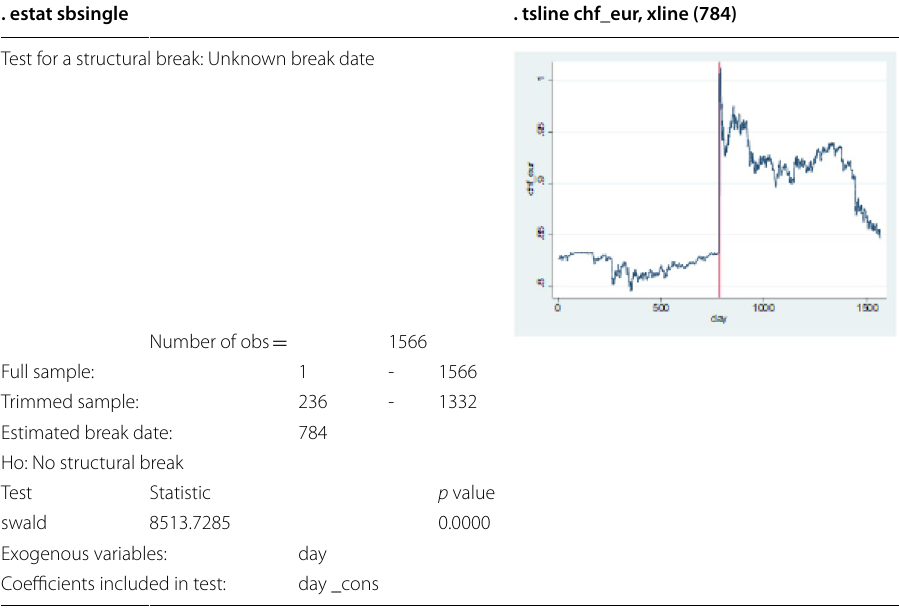
This table indicates that we reject the null hypothesis of no structural break at the 5% level with a high Wald statistic. The estimated break date in the currency price is the 784 observation from the starting 16jan2012. Source : Own calculations